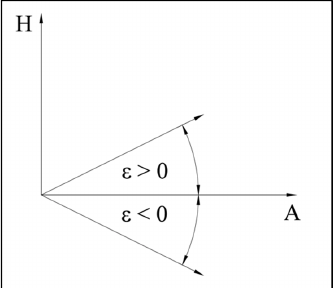
Figure 2. Reference system used when designing HDD trajectories in two–dimensional space.